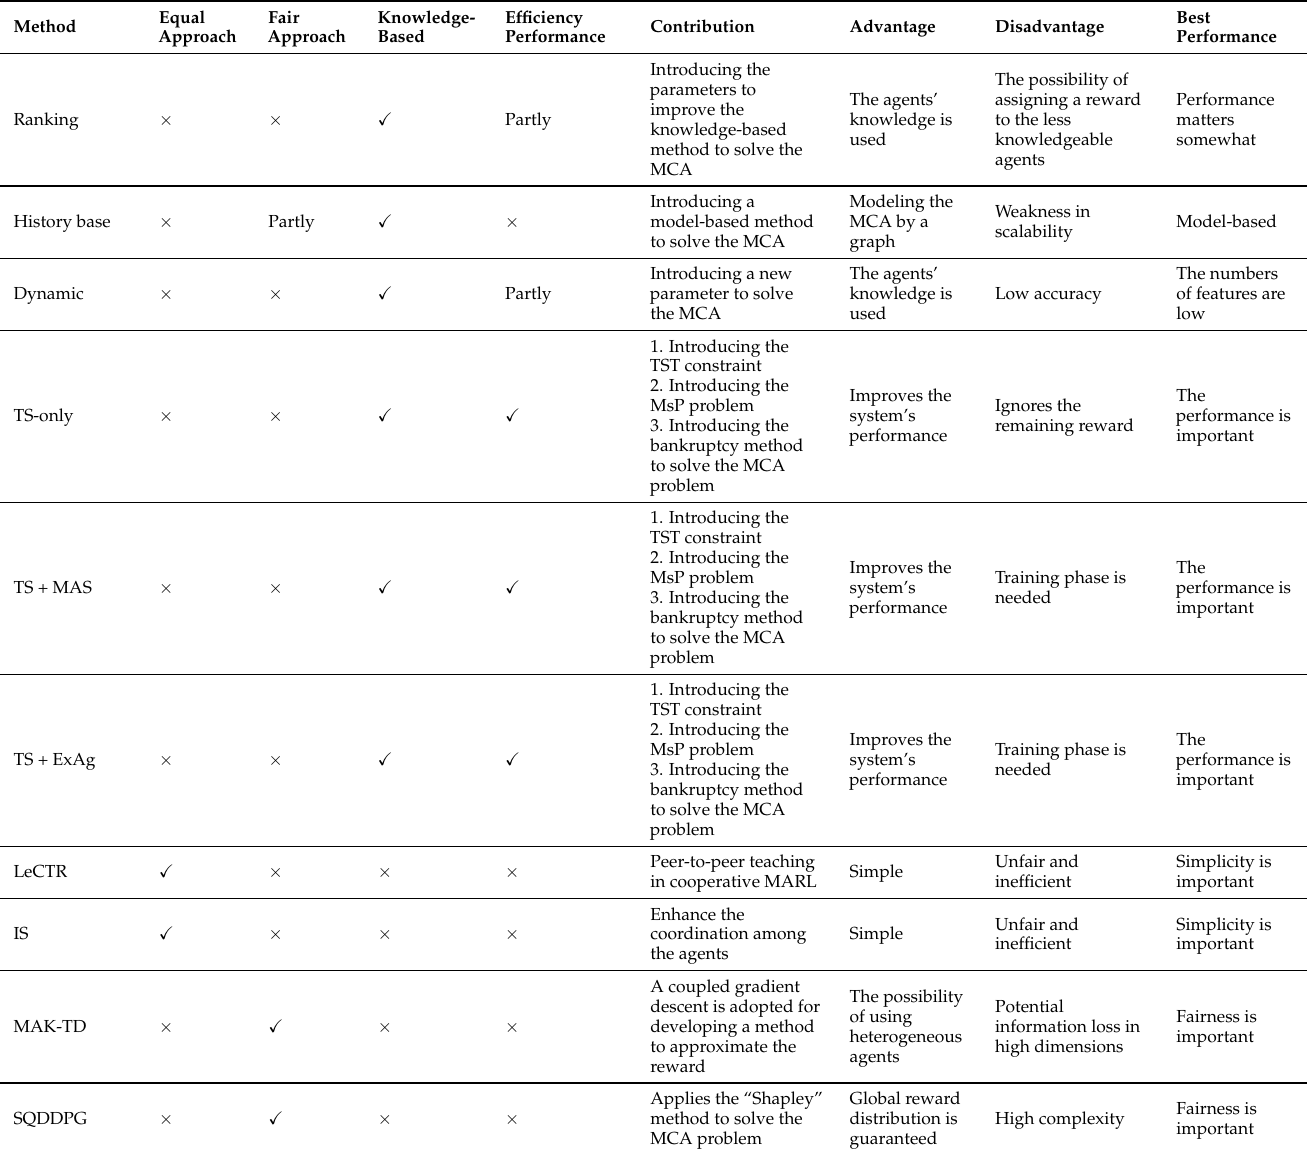
Table 1. Comparing the MCA solving